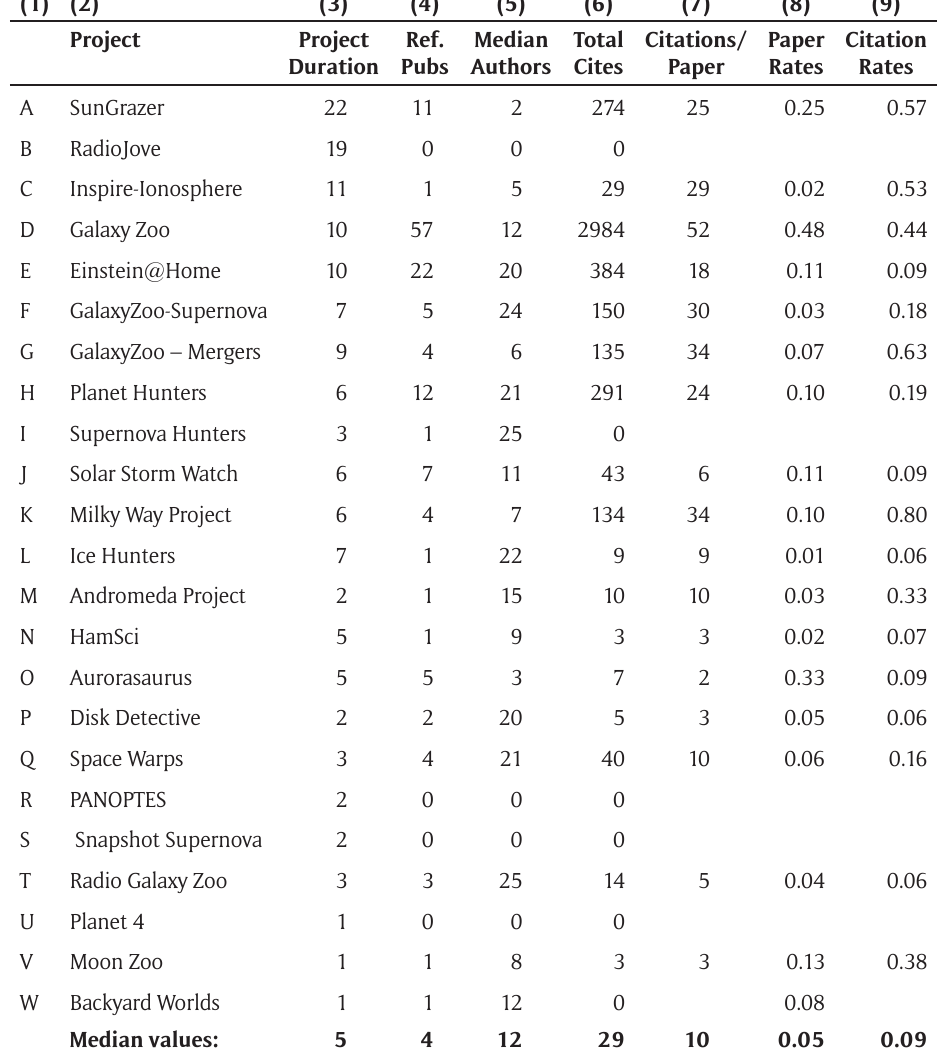
Table 3: CS Paper Publication and Citation